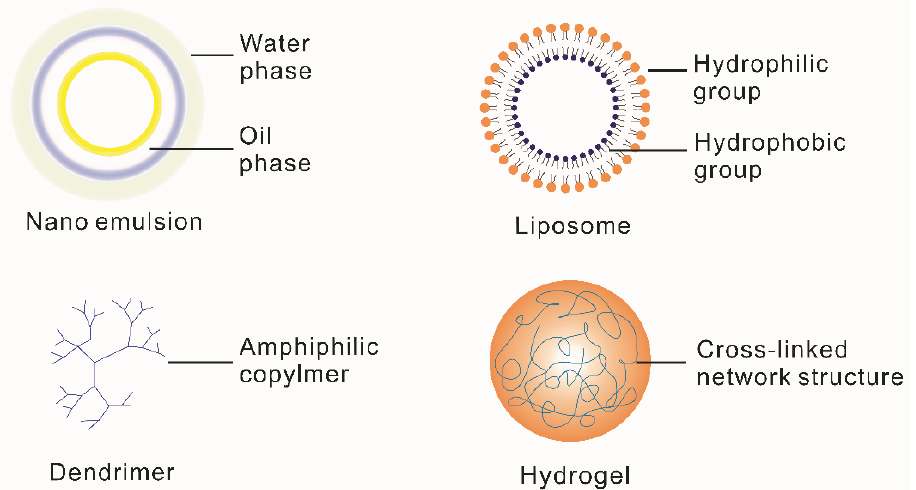
Figure 3. Classification and introduction of special biomimetic nanocarriers for ophthalmic diseases. Nanocapsules are nanoscale vesicle systems composed of nontoxic polymer membranes [65]. Na-